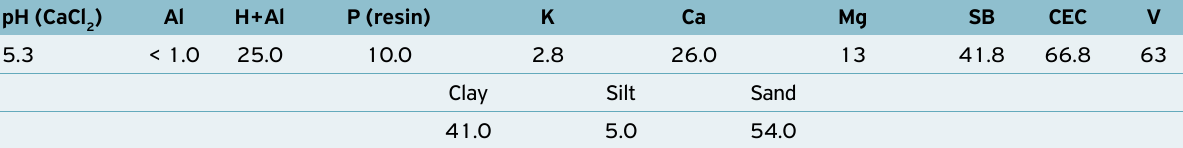
Table 1 . Soil chemical analysis at the 0 ‑ 20 cm depth layer. Piracicaba, state of São Paulo.